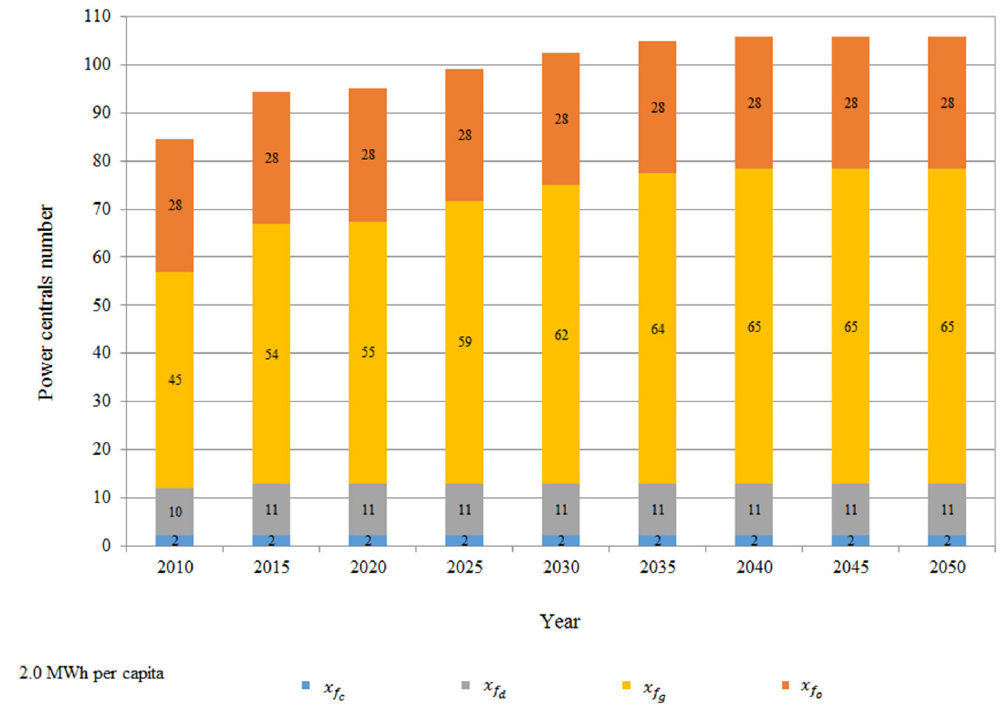
Figure 17. Optimized power plants number from fossil energy resource for 2.0 MWh per capita demand with the CVF model.